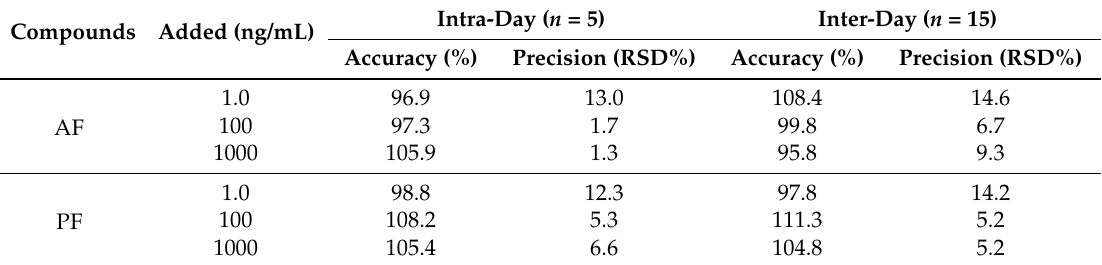
Table 1. Intra-day and inter-day precision and accuracy data of the analytes in rat plasma. Compounds Added (ng/mL)